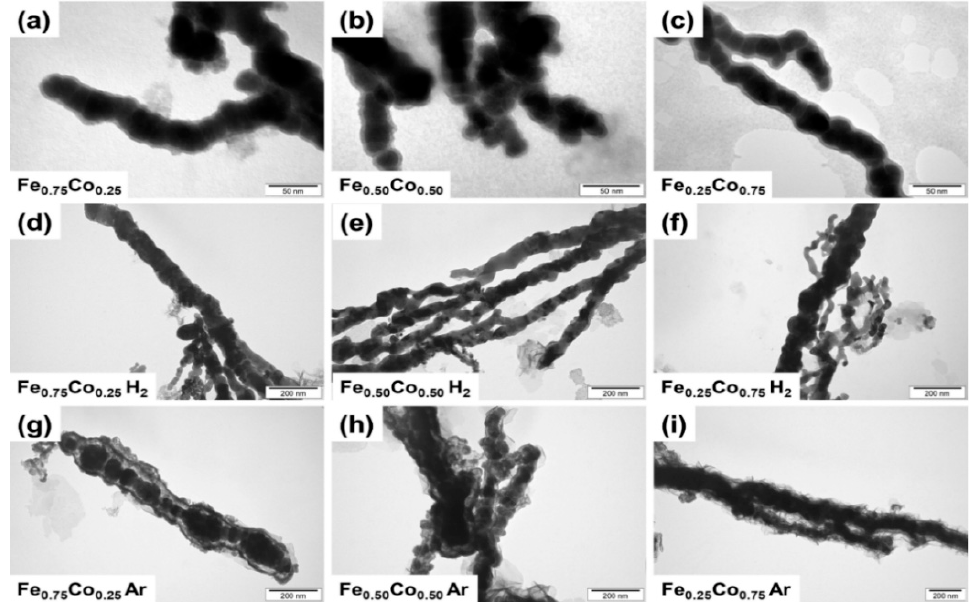
Figure 2. TEM images of as-prepared ( a ) Fe 0.75 Co 0.25 , ( b ) Fe 0.50 Co 0.50 , and ( c ) Fe 0.25 Co 0.75 Wire-like nanochains; TEM images of ( d ) Fe 0.75 Co 0.25 , ( e ) Fe 0.50 Co 0.50 , and ( f ) Fe 0.25 Co 0.75 Wire-like nanochains annealed in hydrogen-containing atmosphere; TEM images of ( g ) Fe 0.75 Co 0.25 , ( h ) Fe 0.50 Co 0.50 , and ( i ) Fe 0.25 Co 0.75 Wire-like nanochains annealed in argon. Table 1. Weight and atomic percentage of elements forming the as-prepared Fe 0.75 Co 0.25 , Fe 0.50 Co 0.50 , and Fe 0.25 Co 0.75 nanochains, and carbon type determined with EDS technique.